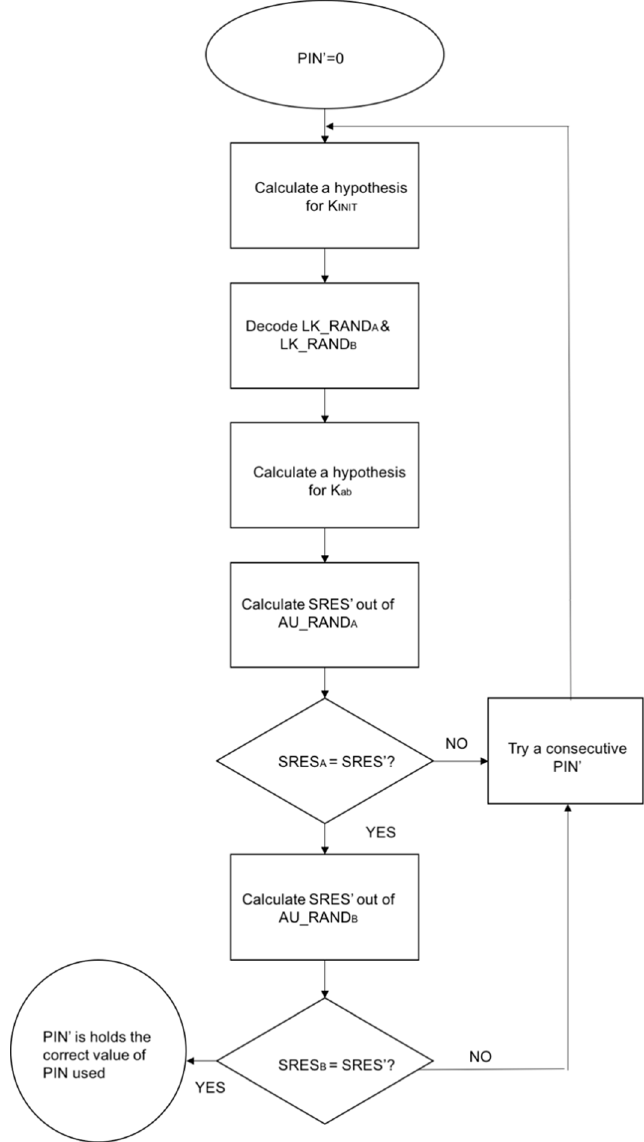
Figure 8. PIN Cracking Attack.